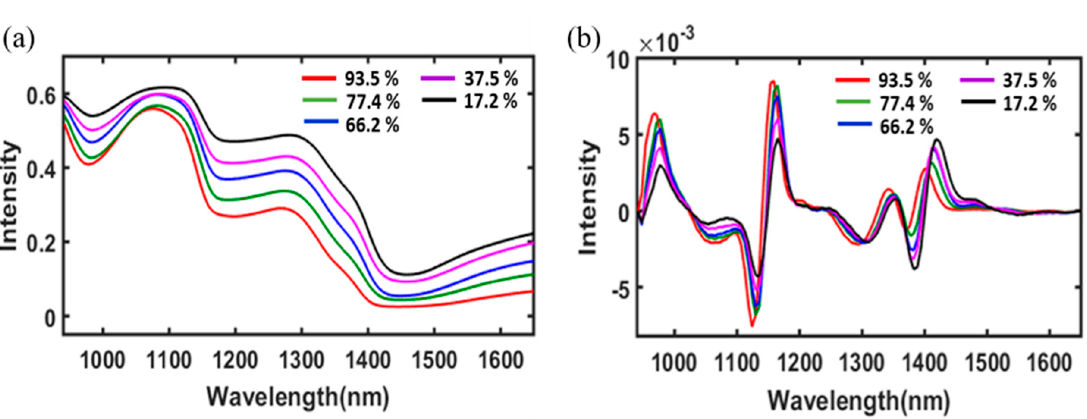
Figure 5. Raw mean spectra ( a ) and Savitzky–Golay (SG) 2nd derivative preprocessed mean spectra (940–1680 nm) of radish slabs with different moisture contents ( b ).